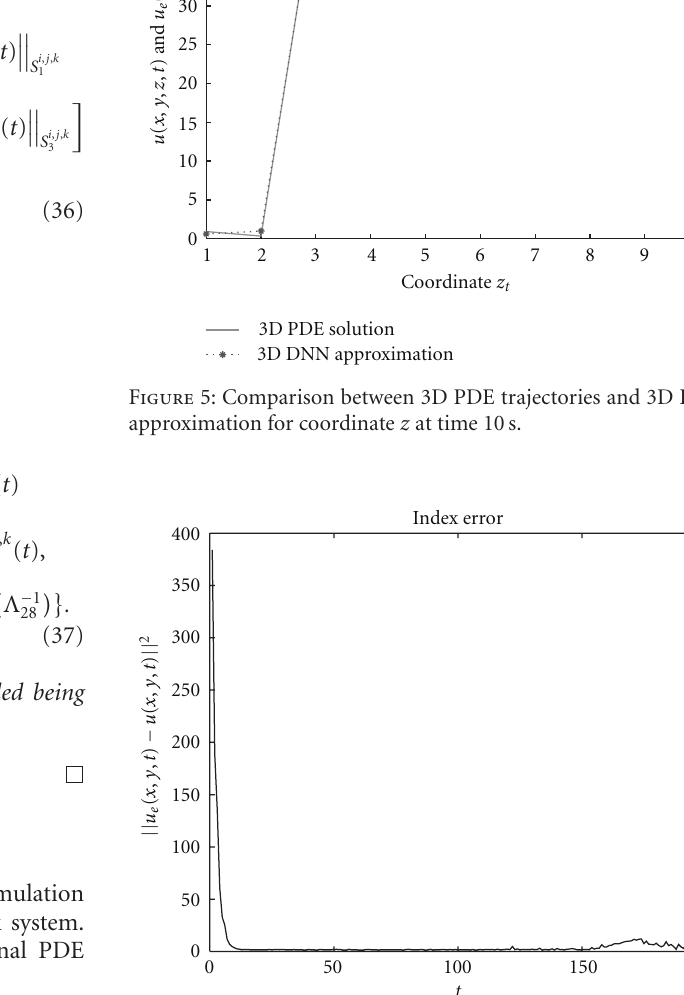
Figure 6: Index quadratic error for the whole time with coordinates x , y , and z